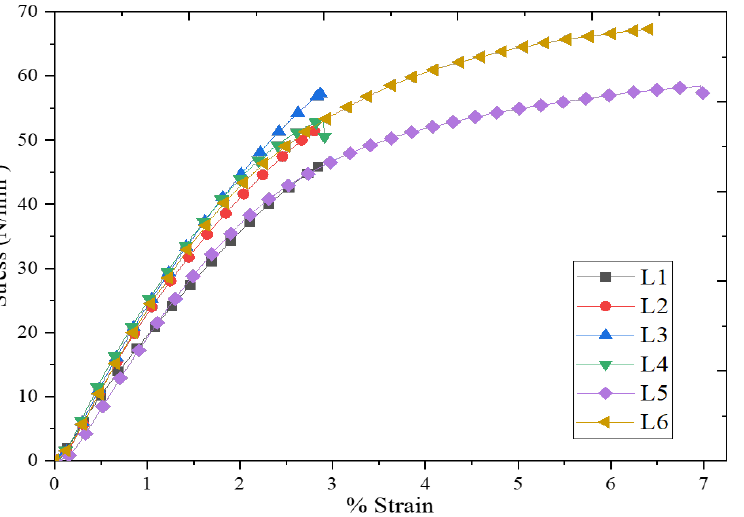
Figure 4. Stress-strain curves of laminates fabricated in the present study (L1: Bamboo + Epoxy; L2: Kenaf + Epoxy; L3: Bamboo + Kenaf + Epoxy; L4: Bamboo + Epoxy + MWCNT; L5: Kenaf + Epoxy + MWCNT; L6: Bamboo + Kenaf + Epoxy +MWCNT).